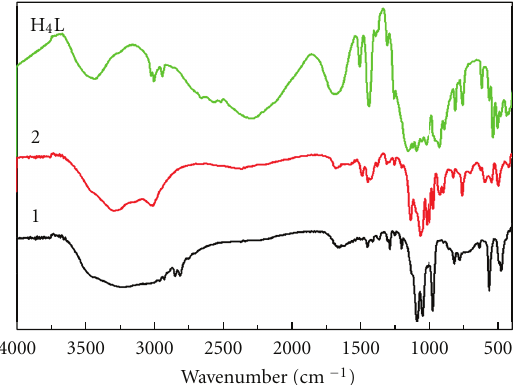
F 2: (a) ORTEP view of 2 showing the atom-labeling scheme (30 supramolecular network of 2 stacked by hydrogen bonds. (Green: Mg, Pink: P, Grey: C, Red: O, Blue: N, White: H). H 4